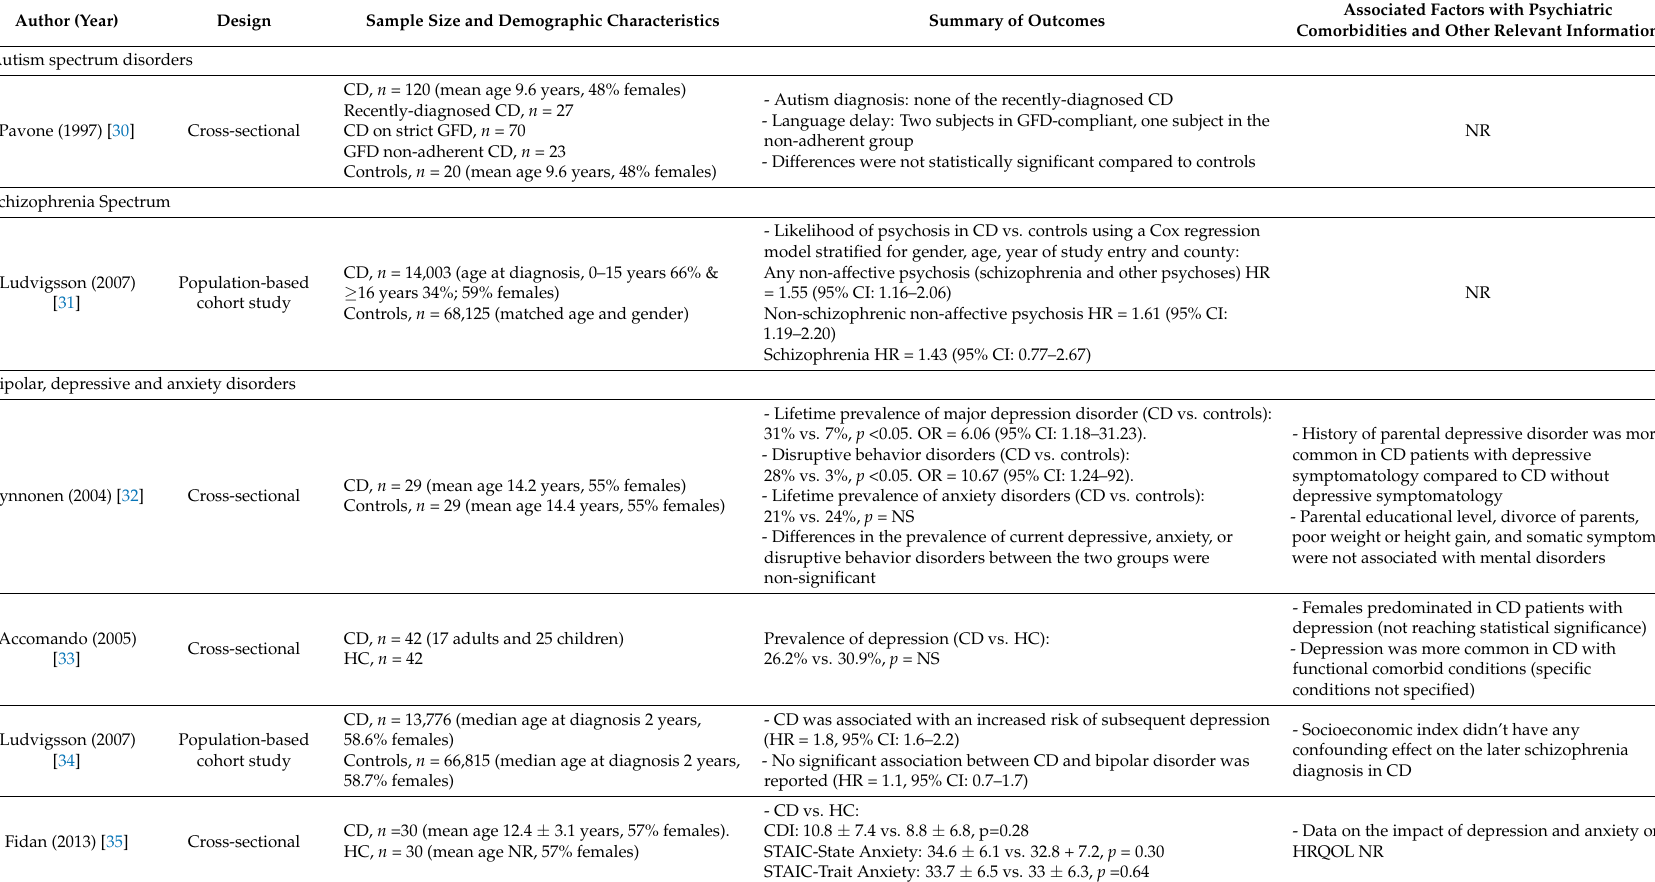
Table 2. Summary of outcomes evaluating the association between gluten-related disorders and psychiatric disorders in children and young